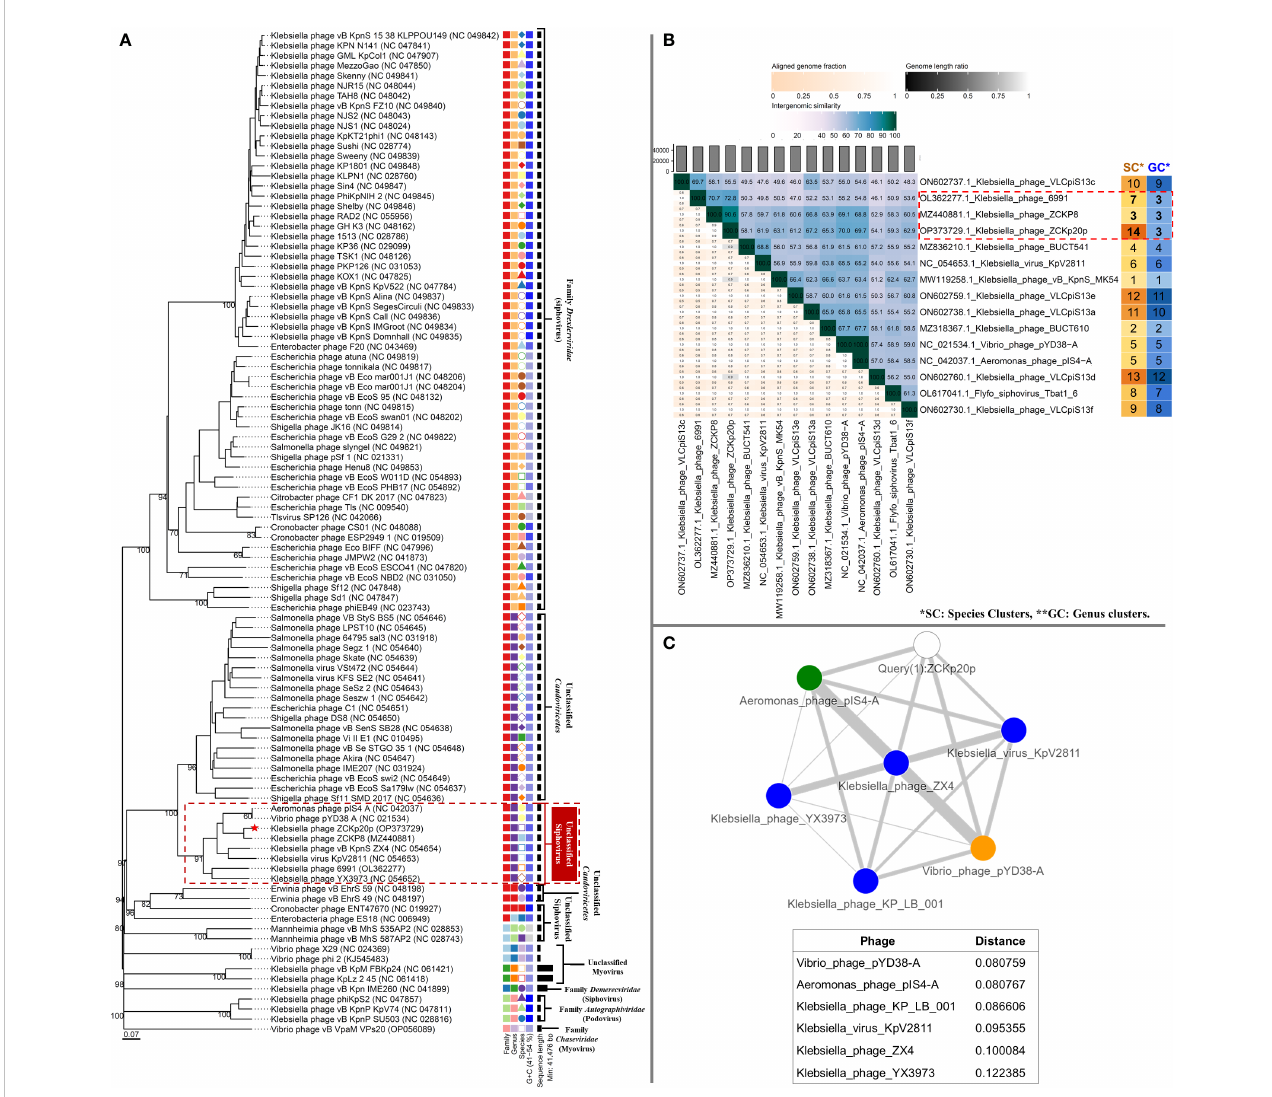
FIGURE 11 Phylogeny of phage vB_Kpn_ZCKp20p. (A) VICTOR genome-based phylogenetic tree conducted by nucleotides pairwise comparison of phage vB_Kpn_ZCKp20p, other Caudoviricetes phages, and closely related phages according to genome BLASTn top hits. The phages were clustered into 6 families, 10 genera, and they were clustered into 94 species. The GC content of the phage genomes is represented in the hue of blue color, and the genome size is presented in horizontal black lines on the right side. (B) VIRIDIC heatmap for the intergenomic similarity between phage vB_Kpn_ZCKp20p and closely related phages according to genome BLASTn top hits. Three factors of the alignment capacity were considered to calculate the relatedness between the phages: intergenomic similarities (hue of green to blue), the percentage of aligned genome sequence in a pair (shade of pink) and their length ratio (shade of black). (C) PhageCloud analysis of phage vB_Kpn_ZCKp20p genomic relationship with the closest reference phage genomes on NCBI-GenBank. Intergenomic distances were calculated by dashing based on a threshold of